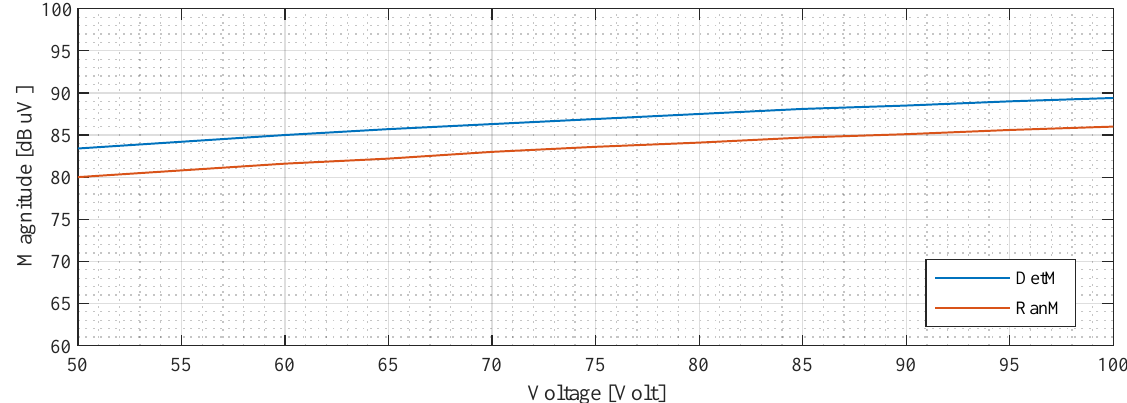
Figure 12. The maximum amplitude of disturbances, measured at the grid terminal (point 1, Figure 3) depending on the converter supply voltage for different modulation schemes (DetM and Ran) for IFBW = 9